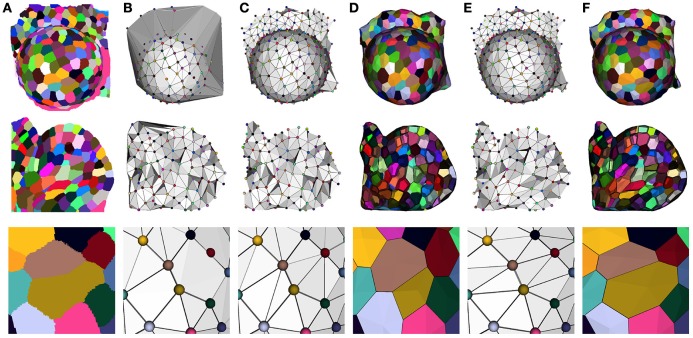
Constructing a dual geometry by the optimization of the cell adjacency simplicial complex: initial segmented image (A), Delaunay tetrahedrization (B) and cleaned adjacency complex (C), Voronoi diagram obtained by the dualization of the cleaned Delaunay complex (D), optimized adjacency complex (E) and dual tissue reconstruction (F). The cell complexes in (D,F) are triangulated for visualization.